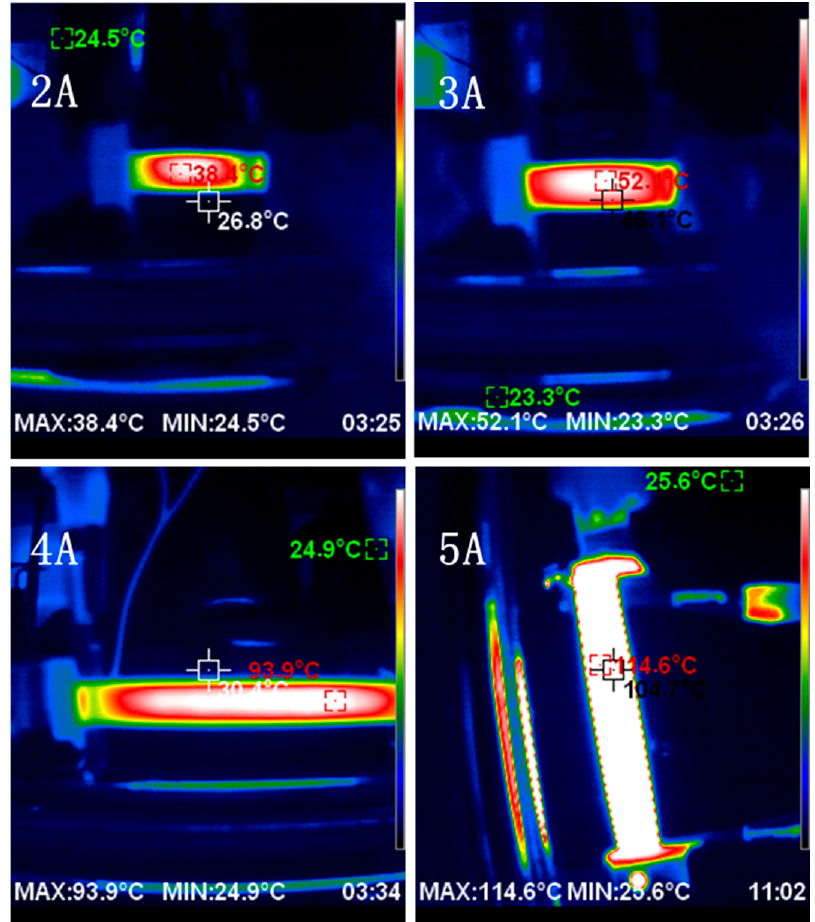
Figure 4. Infrared thermal imaging of CFRE plates with different conduction currents.